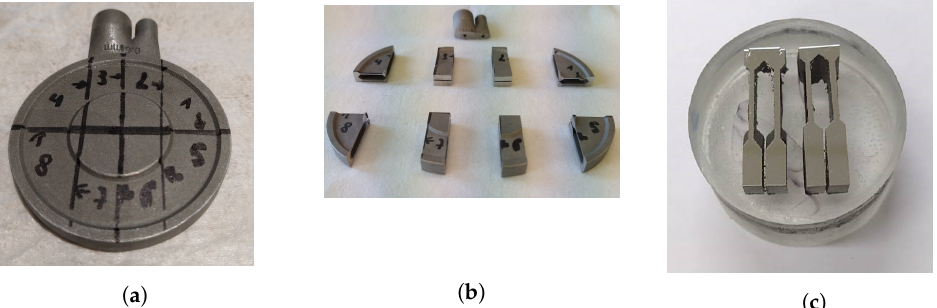
Figure 4. The prototypes are prepared for microscopy by cutting them in eight pieces (plus threaded hydraulic connection, which is discarded), putting them into epoxy embedding material to sub- sequently grind and polish them. ( a ) Top view of the of the prototype before cutting. The parts are marked and numbered before cutting. ( b ) Top view of the eight cut pieces (and the threaded connections) after cutting. ( c ) View of one of the cut pieces in the embedding material after grinding and polishing, ready for the